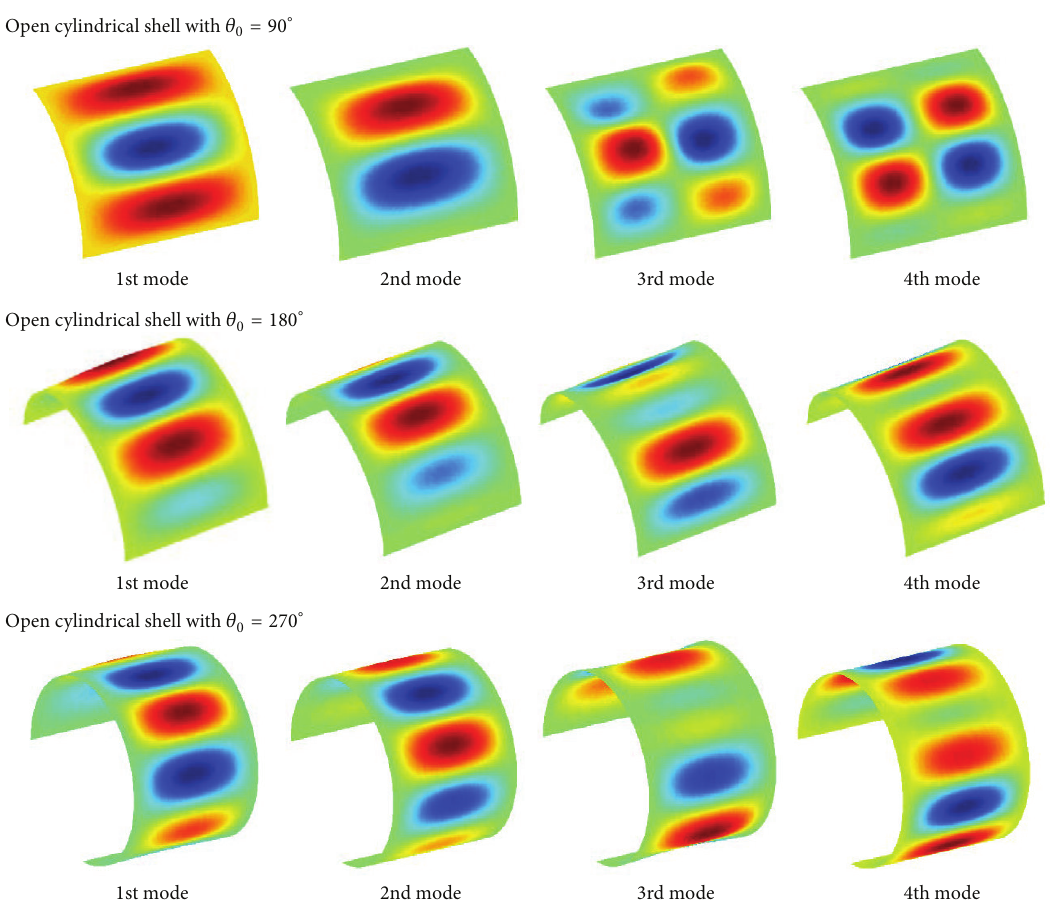
Figure 6: First four mode shapes for an open cylindrical shell with E 3 -C-E 3 -C boundary